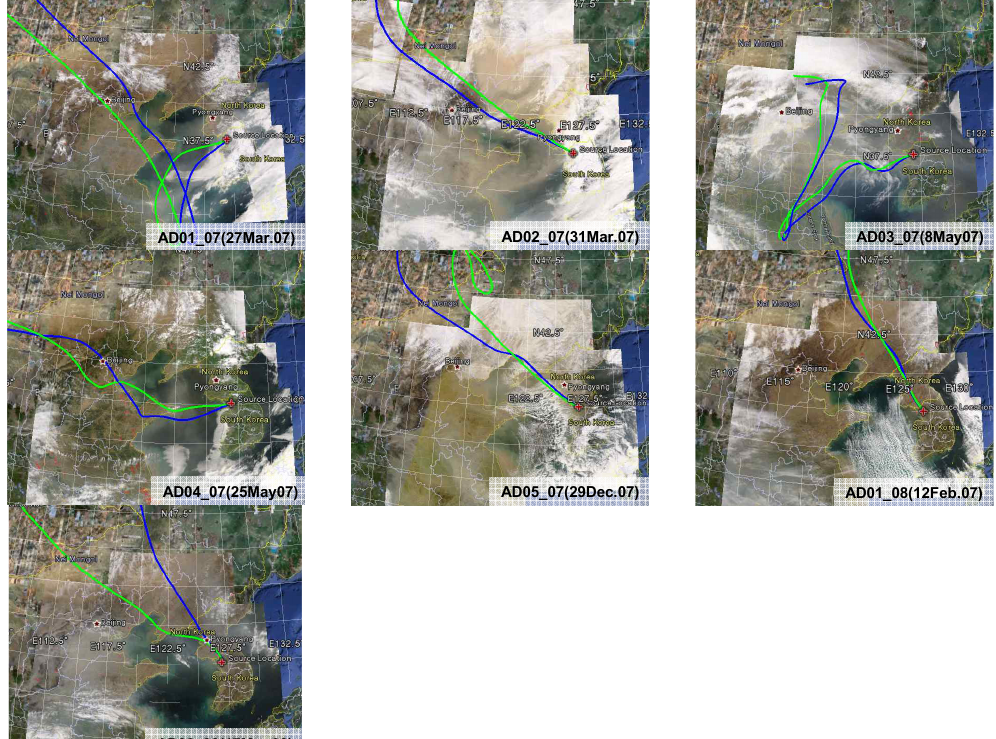
Fig. 12. MODIS RGB images and back-trajectories during the Asian dust periods arriving at the measurement site. Blue and yellowish green are back-trajectories arriving at 500 and 1000m altitudes,